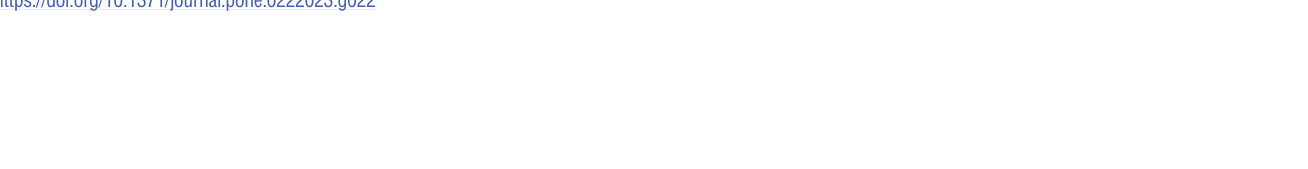
PLOS ONE | https://doi.org/10.1371/journal.pone.0222023 September 11, 2019 28 /